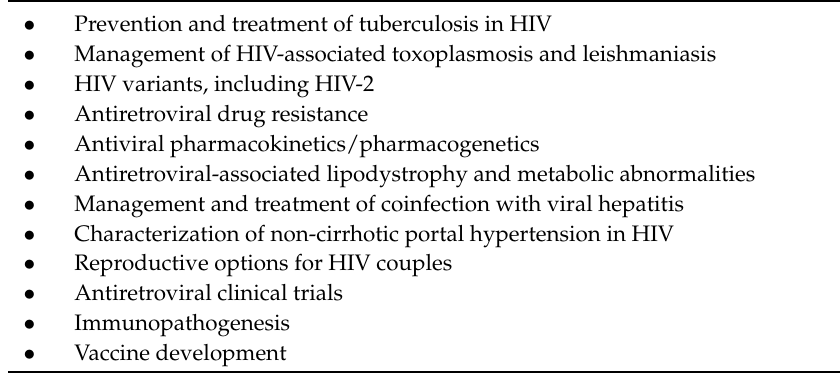
Table 1. Major contributions of Spanish HIV